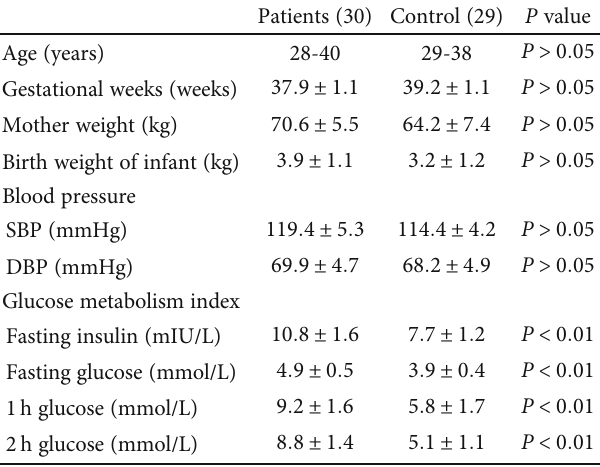
Table 1: Characteristics. Patients (30) Control (29) P